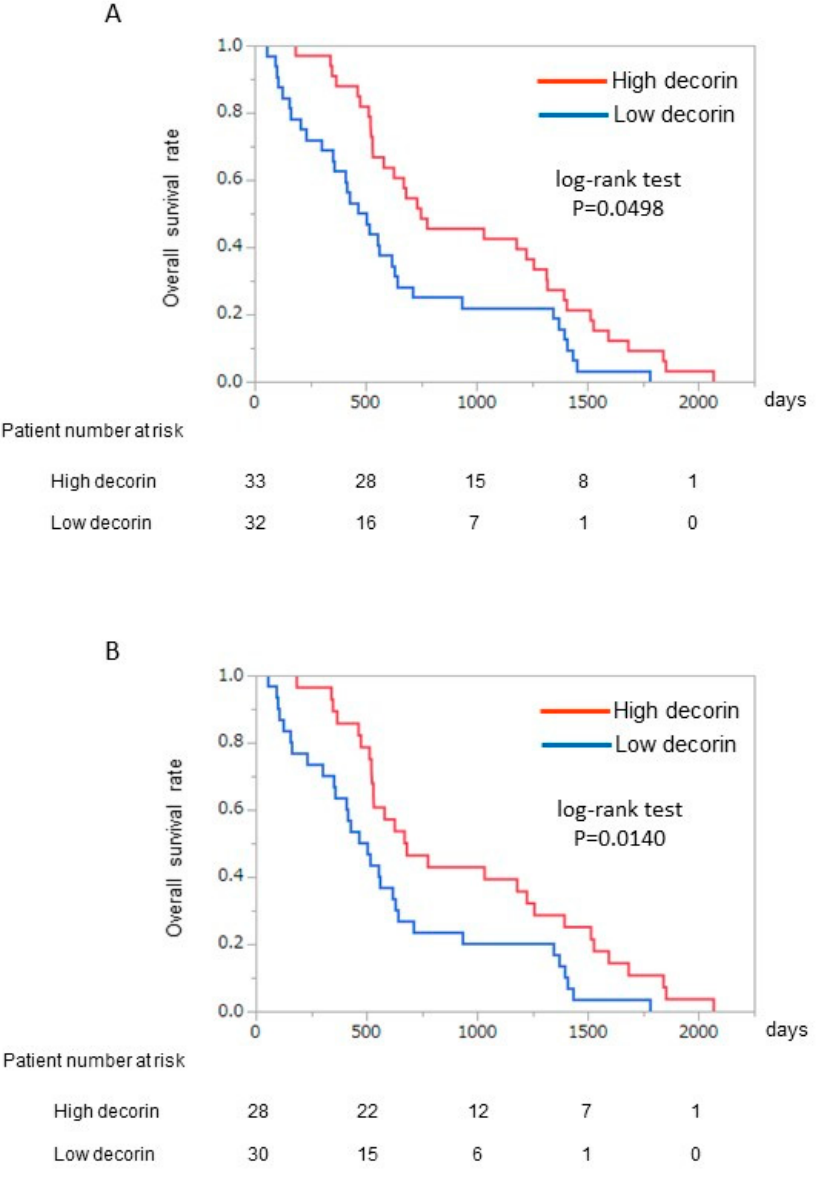
Figure 2. Kaplan–Meier analysis between the High decorin and Low decorin groups. ( A ) All patients; ( B ) Patients with BCLC stage B HCC. BCLC, Barcelona Clinic Liver Cancer; HCC, hepatocellular